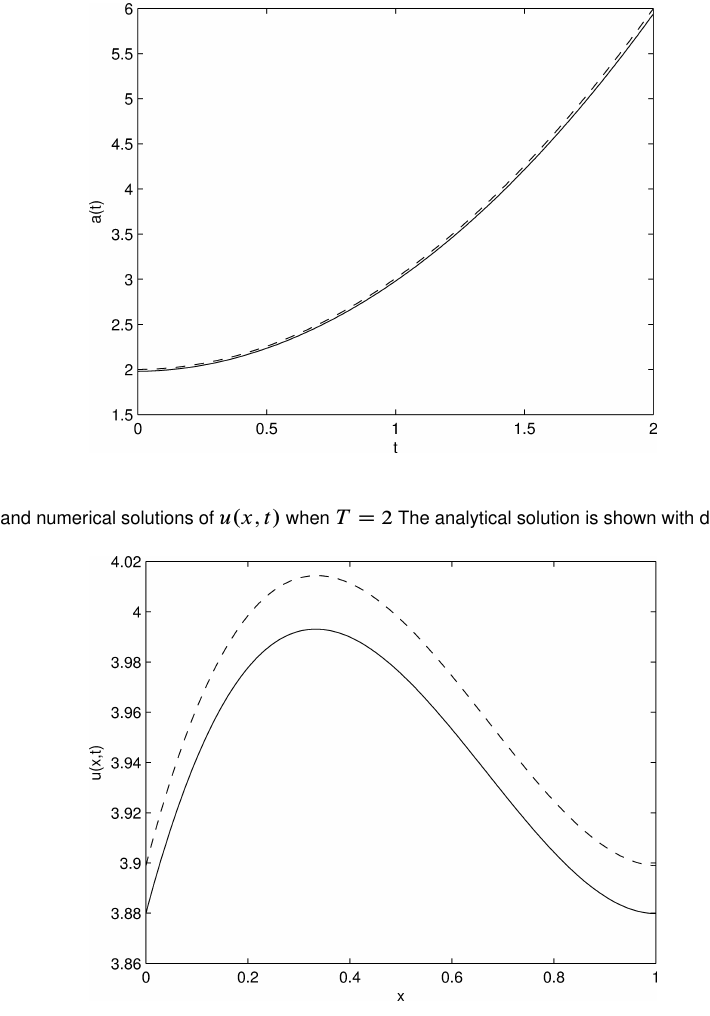
Fig. 1. The analytical and numerical solutions of a.t/ when T D 2 The analytical solution is shown with dashed line.